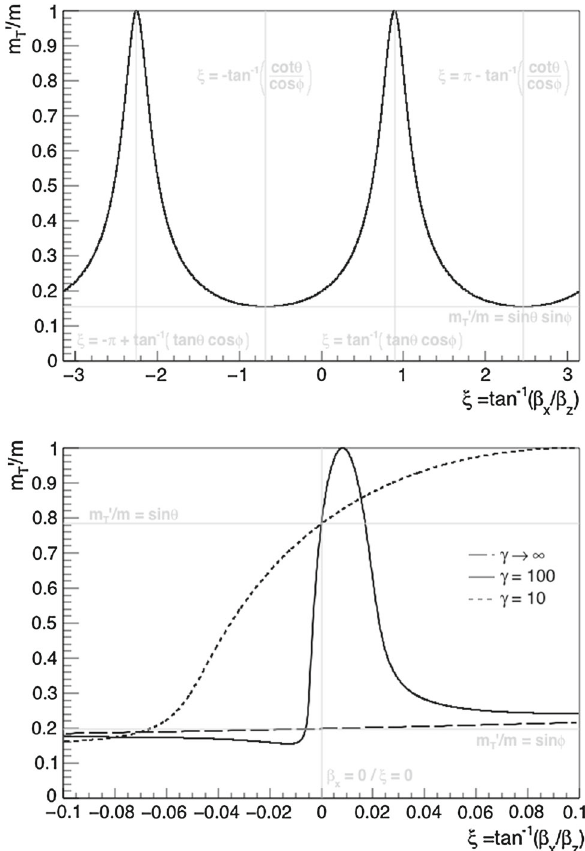
Fig. 4 Top: values of m (cid:3) normalised to m plotted as a function of ξ T for θ = 0 . 9 and φ = 0 . 2 for γ → ∞ . The positions of the maxima and minima given by Eqs. 12 and 14 are denoted by light grey lines, / m = sin θ sin φ = 0 . 156. Bottom: an as is the minimum value of m (cid:3) T enlargement of the top panel around ξ = 0 (i.e. β x = 0) with curves for several other large, but finite, values of γ also shown. The two limiting / m are shown – namely m (cid:3) / m = sin φ = 0 . 199 when values of m (cid:3) T T γ → ∞ and m (cid:3) / m = sin θ = 0 . 783 when β = x T